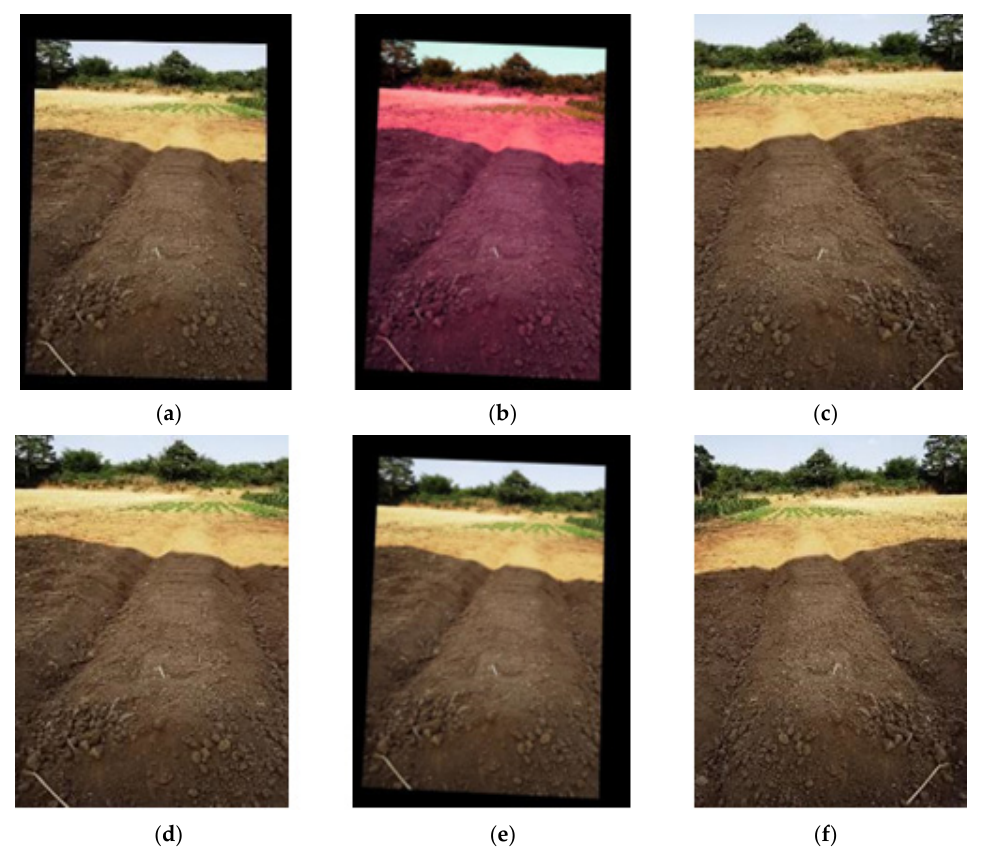
Figure 2. Image enhancement. ( a ) Distorted projection. ( b ) Color enhancement. ( c ) Random cropping. ( d ) Random flip. ( e ) Revolve. (f) Original.